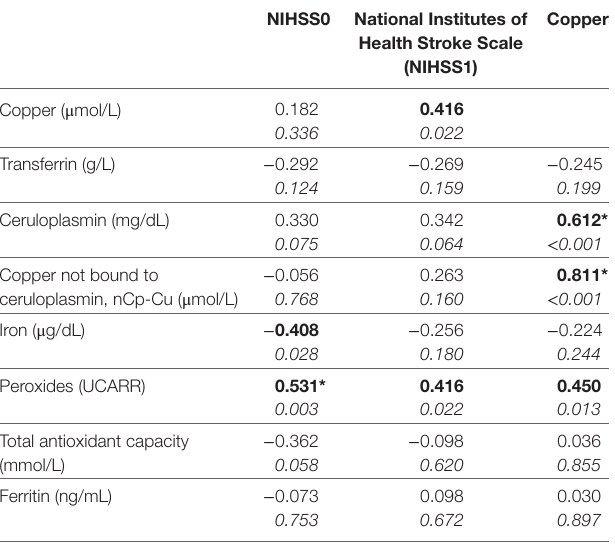
Table 3 | Correlations between clinical and biological variables.